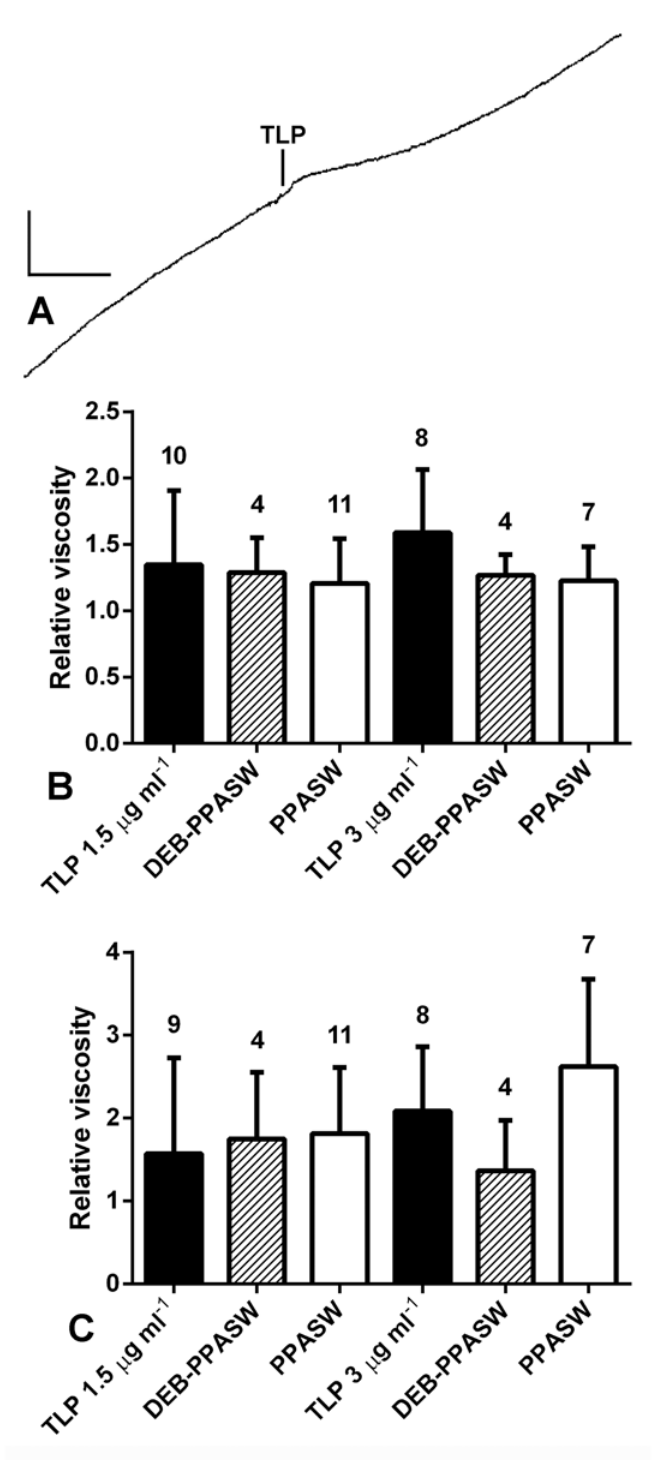
Fig 6. Effect of tensilin-like protein (TLP) on the creep behaviour of P . lividus CDs. (A) Recording of a response to 3.0 μ g ml -1 TLP; vertical scalebar, 0.2 mm; horizontal scalebar, 60 s. (B, C) Effect of TLP on relative viscosity. CDs were treated with TLP at concentrations of 1.5 μ g ml -1 and 3.0 μ g ml -1 ; separate DEB- PPASW and PPASW controls were used for each concentration. (B) Mean relative viscosities for the time period 15 – 75 s after the start of TLP treatment. (C) Mean relative viscosities for the time period 5 – 6 min